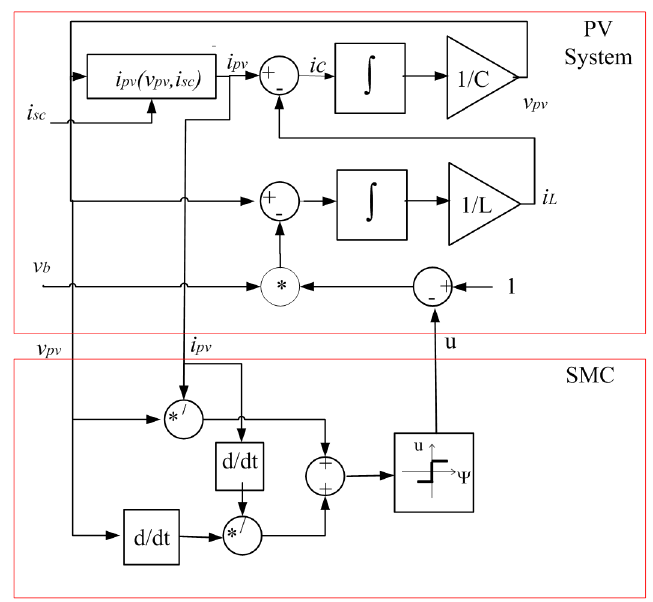
Figure 5. Block diagram of the SMC and PV system.